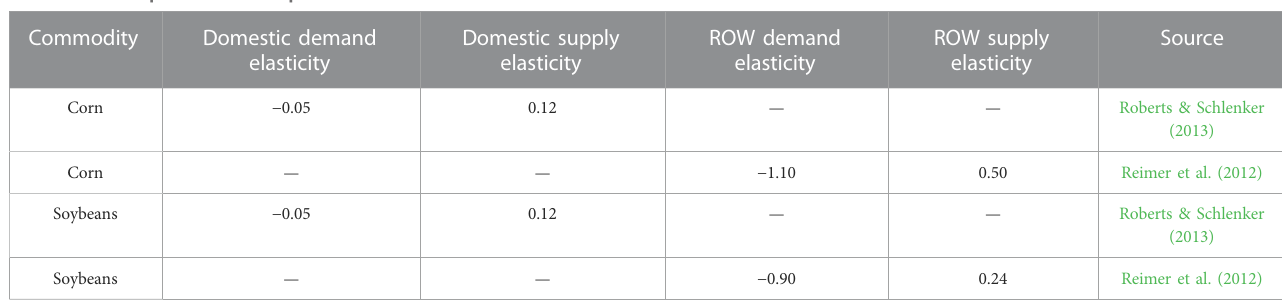
TABLE 1 FEWSVT price elasticities speci fi ed in heat-wave